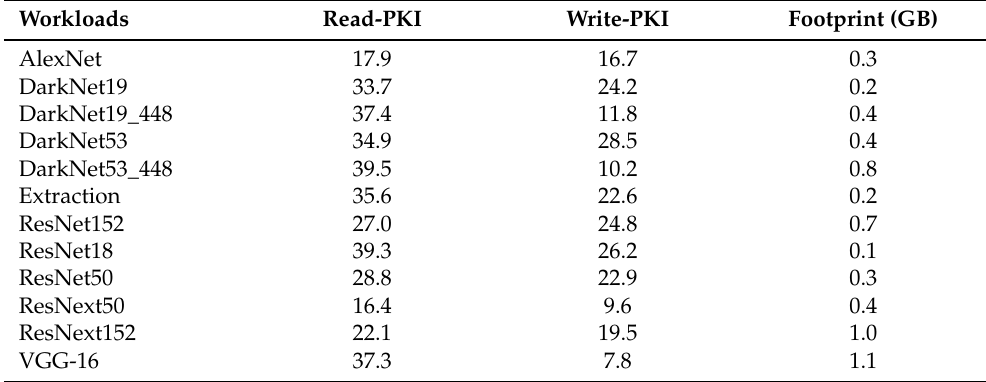
Table 5. Memory access per kilo instructions and memory footprint.